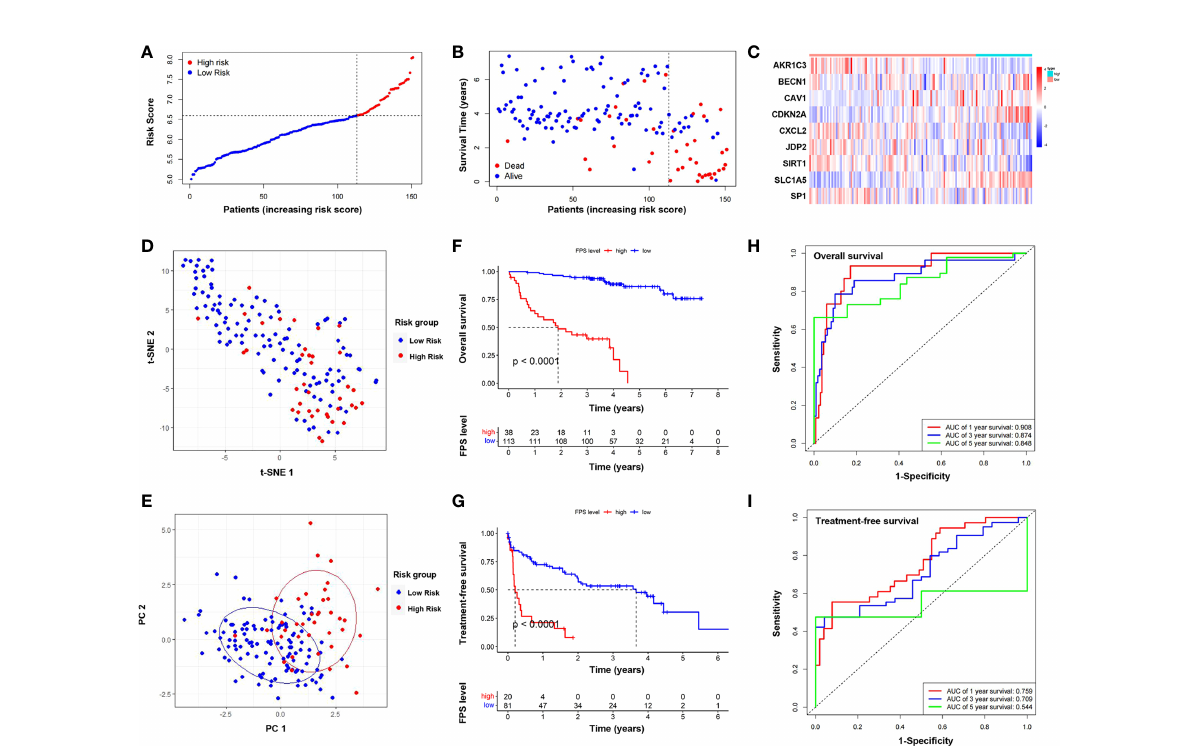
FIGURE 3 Establishment and assessment of the novel ferroptosis-related gene risk score model. (A) The distribution and optimal cutoff value of risk scores in training cohort. (B) The distributions of OS status, OS, and risk score. (C) Heatmap of the expression levels of the nine selected FRGs. (D) t- SNE plot of the CLL cohort. (E) PCA plot of the CLL cohort visualizing the distribution of the low- and high-risk groups. Kaplan – Meier survival curves for OS (F) and TFS (G) of CLL patients strati fi ed by FPS risk score. Time-dependent ROC curves of the risk model for predicting the 1-, 3-, and 5-year OS (H) and TFS (I)